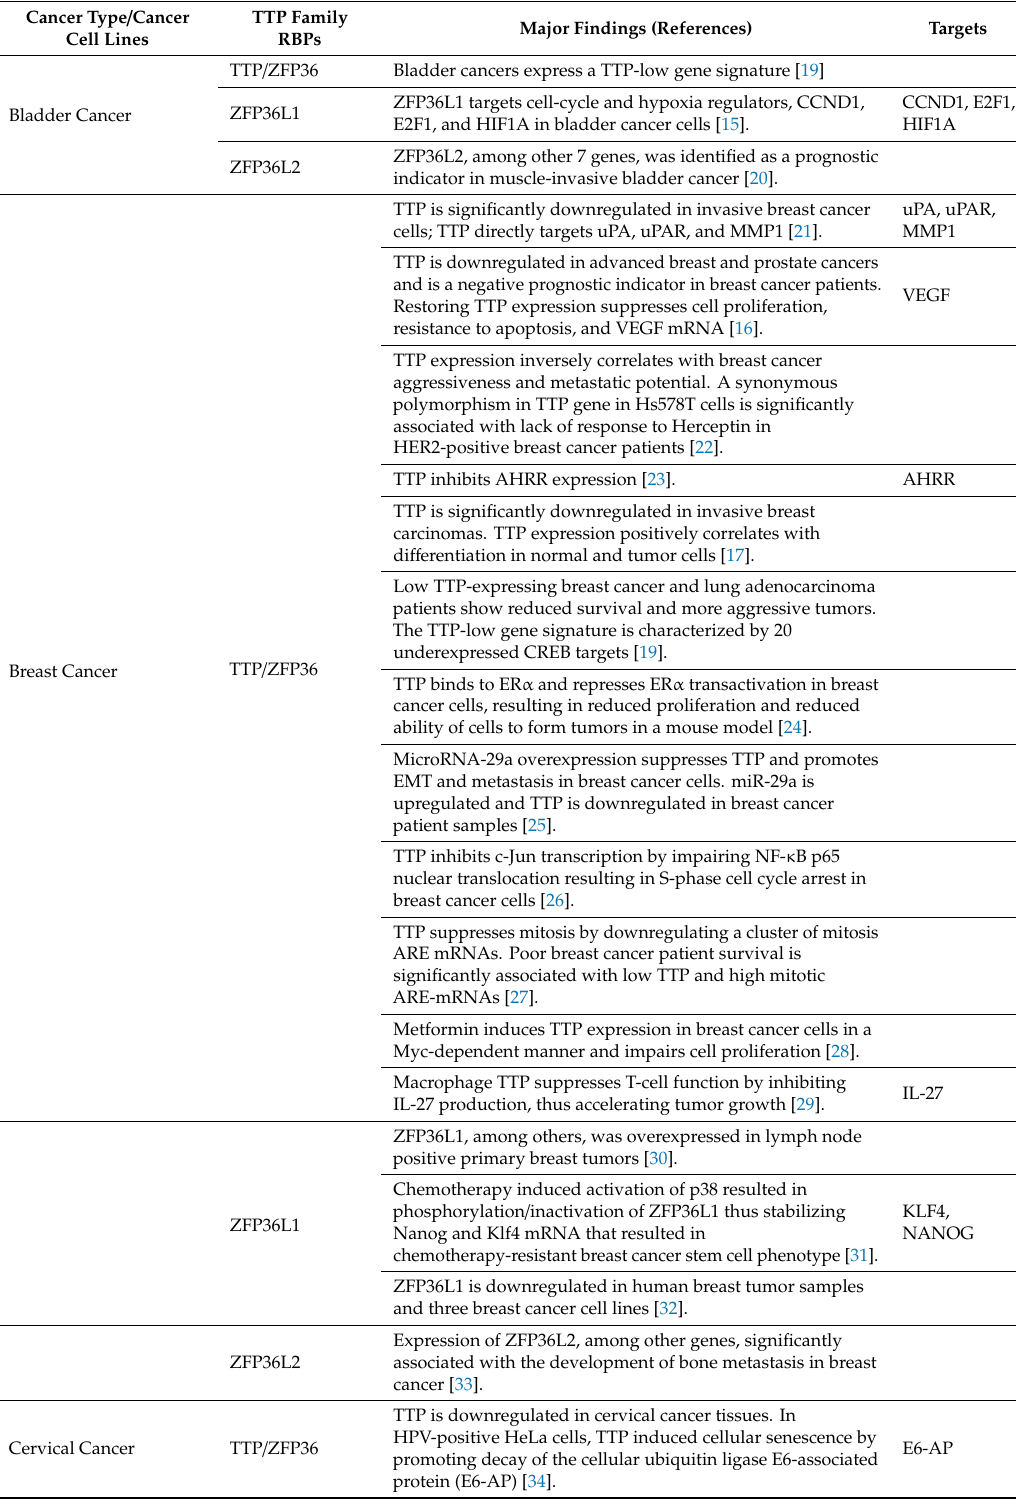
Table 2. TTP family of RNA-binding proteins in various